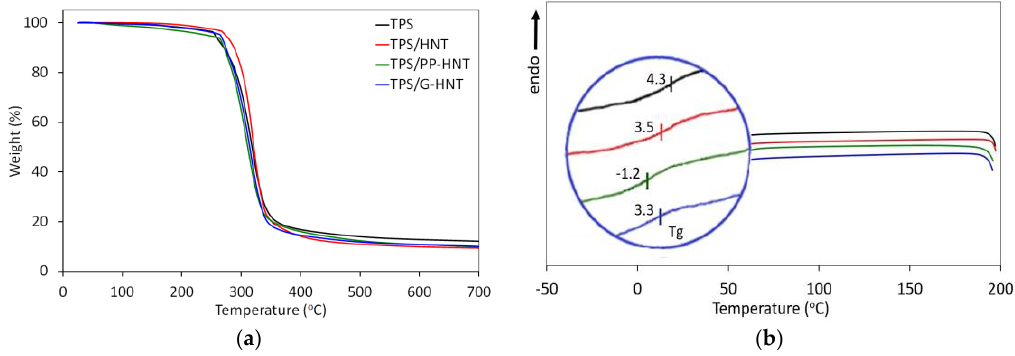
Figure 9. TGA ( a ) and DSC ( b ) thermograms of unmodified and modified TPS.